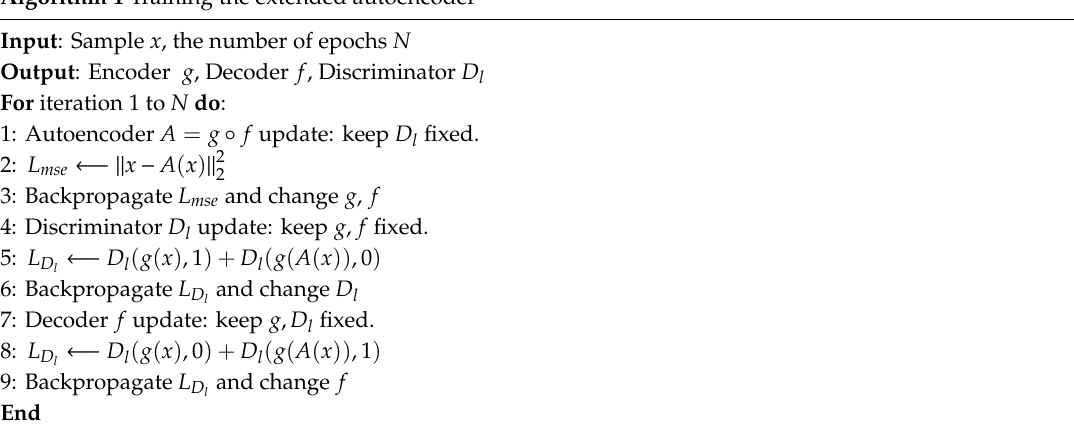
Algorithm 1 Training the extended